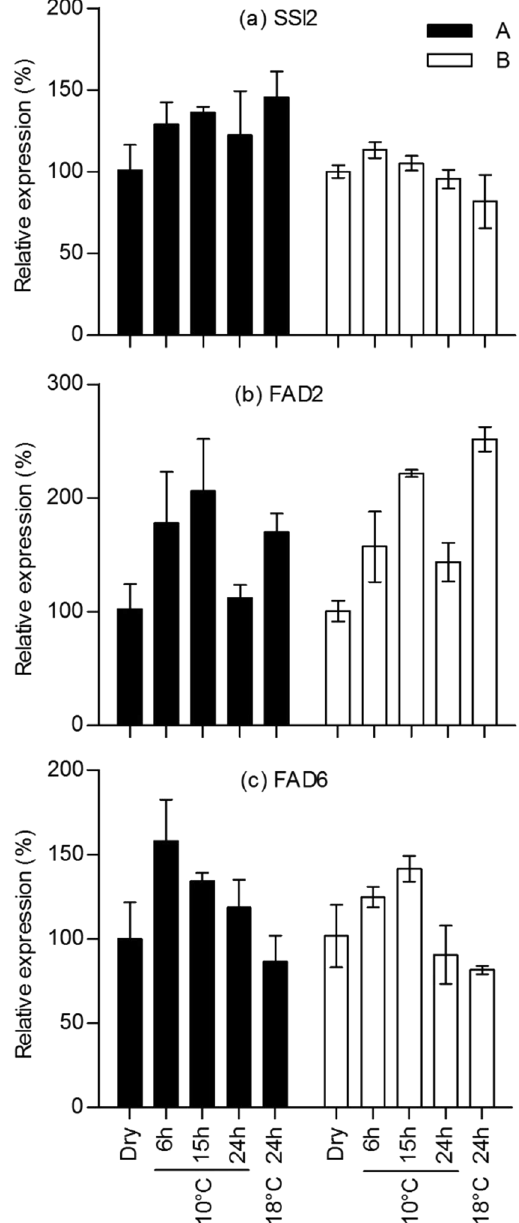
Figure 7. Transcript abundance of desaturase transcripts in maize embryos. Expression of ssi2 ( a ), fad2 ( b ) and fad6 ( c ) in dry embryos of hybrid A (black bars) and hybrid B (white bars) and various durations of imbibition at 10 °C or 18 °C. The relative expression was calculated from qRT-PCR data with 3 references genes, cdk, 2og-fe and unknown, and expressed in arbitrary units with a value of 100 attributed to the dry seeds. Means ± SD of three biological replicates are